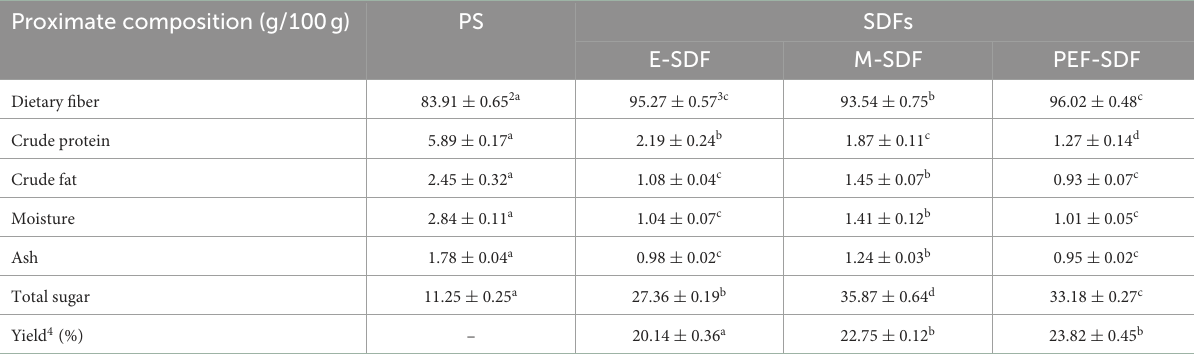
TABLE 1 Proximate composition of peanut shell (PS), enzymatic extraction (E-SDF), microwave extraction (M-SDF), and pulsed electric field extraction (PEF-SDF) 1 . Proximate composition (g/100g)